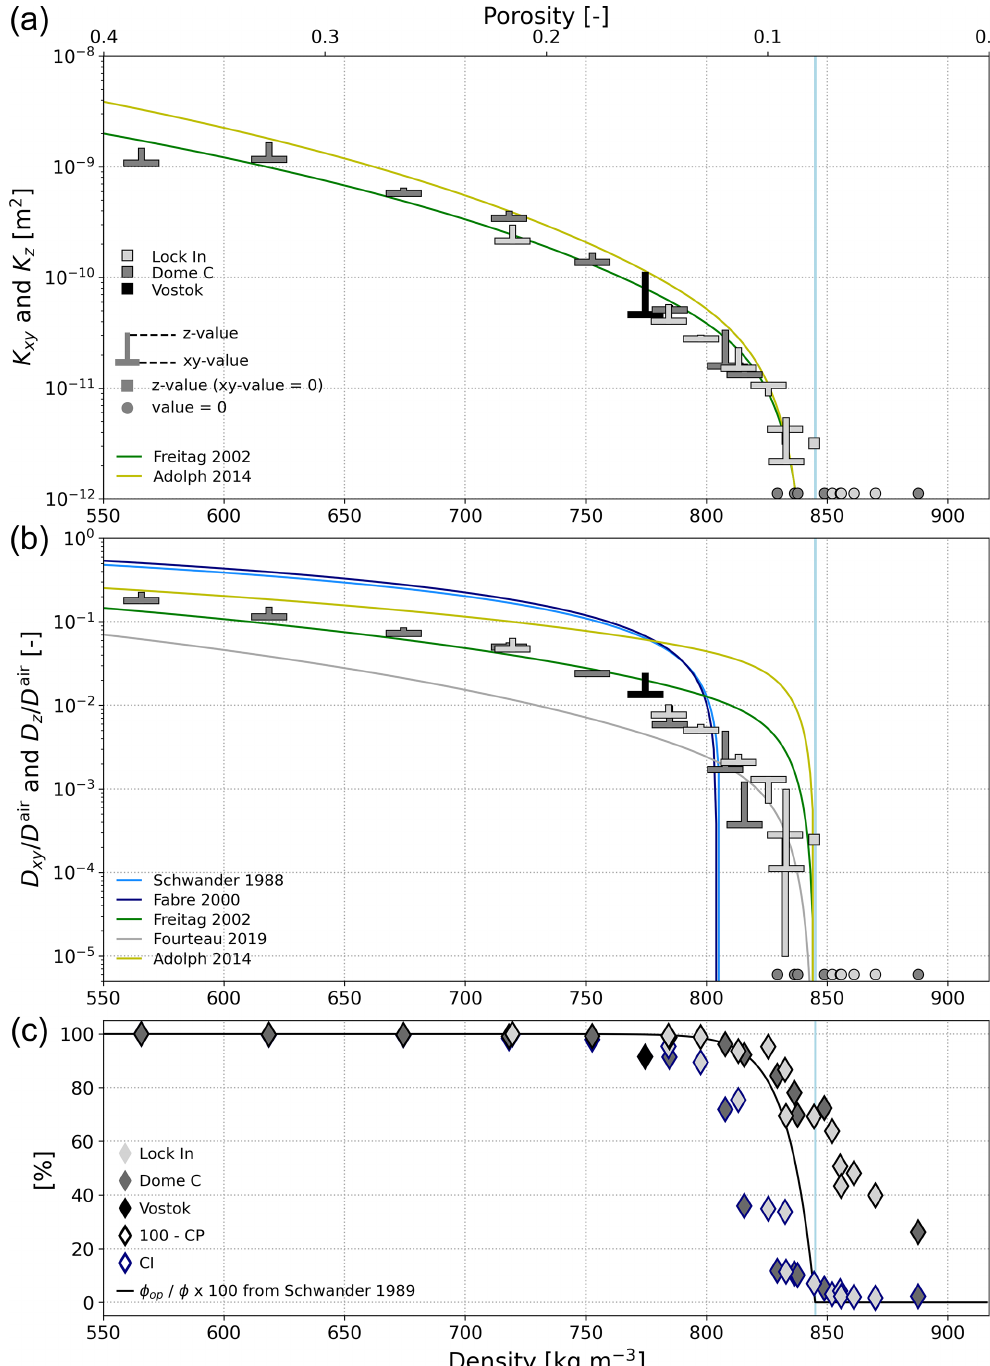
Figure 5. (a, b) Permeability and normalized diffusion coefficient of firn versus density: computations (“T” symbols) and regressions from the literature (lines). (c) Evolution with density of the open porosity fraction based on the closed-to-total porosity fraction CP and based on the open porosity from Schwander 1989, as well as the connectivity index CI. The vertical blue lines at 845kgm − 3 indicate the close-off